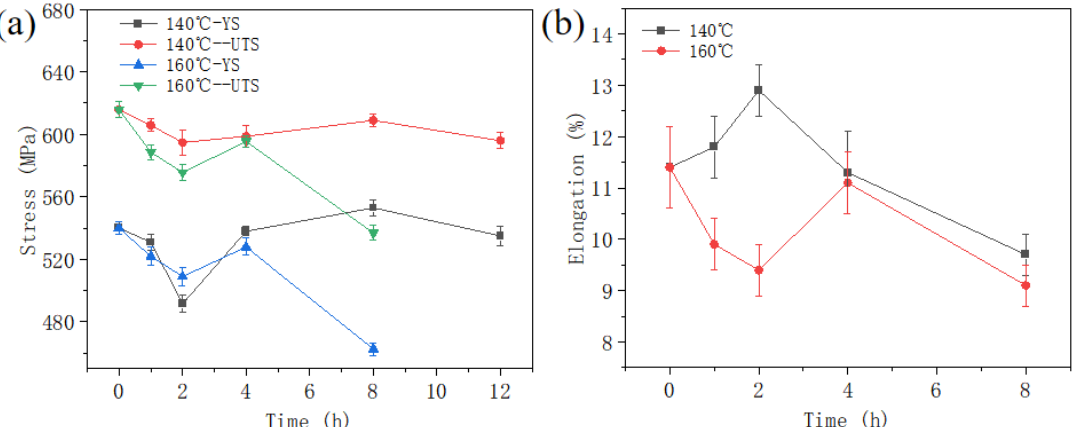
Figure 5. Mechanical properties of 7B04-P al alloy after different creep aged at 140 °C and 160 °C: ( a ) Ultimate tensile strength and yield strength; ( b ) Elongation.